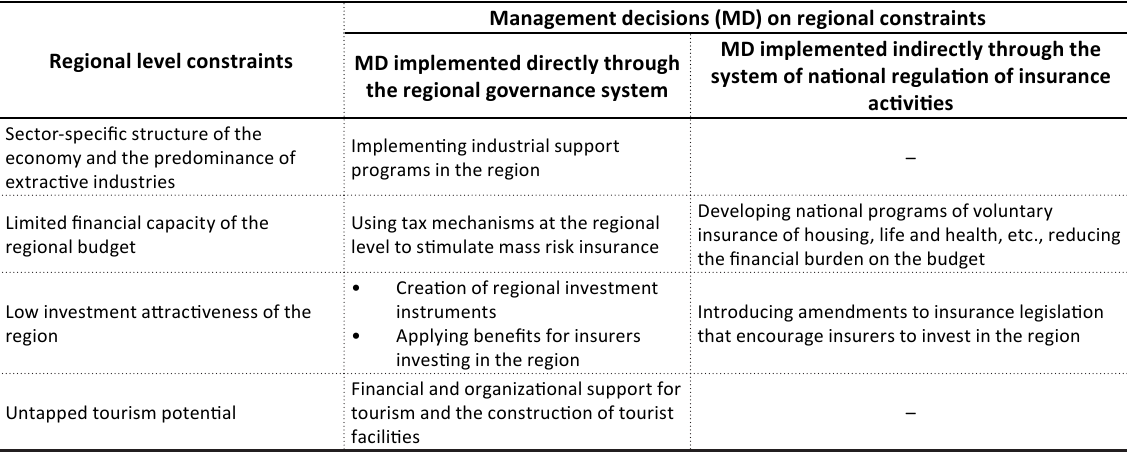
Table 6. Managing regional constraints affecting the RIM development in